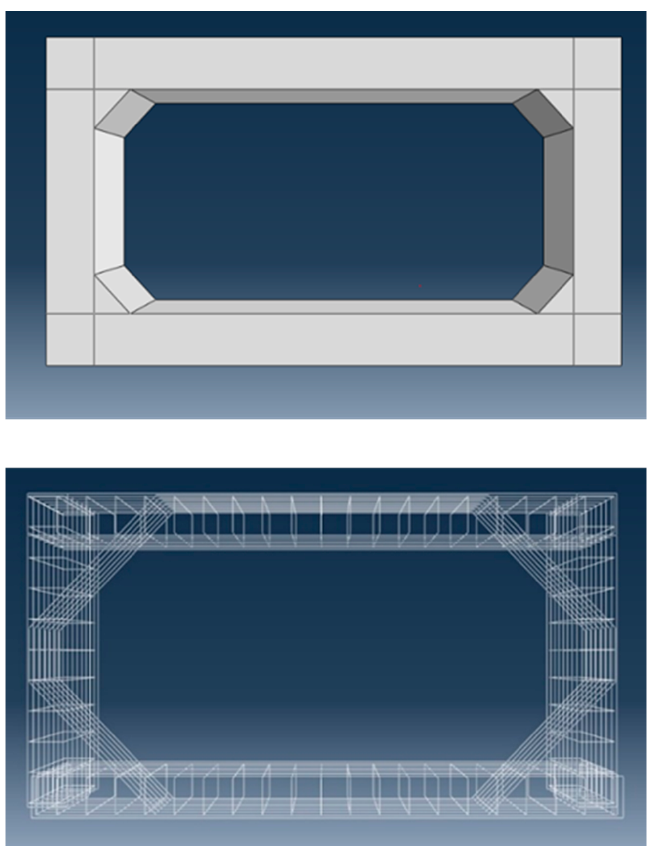
Figure 9. Arrangements of NSM reinforcement.